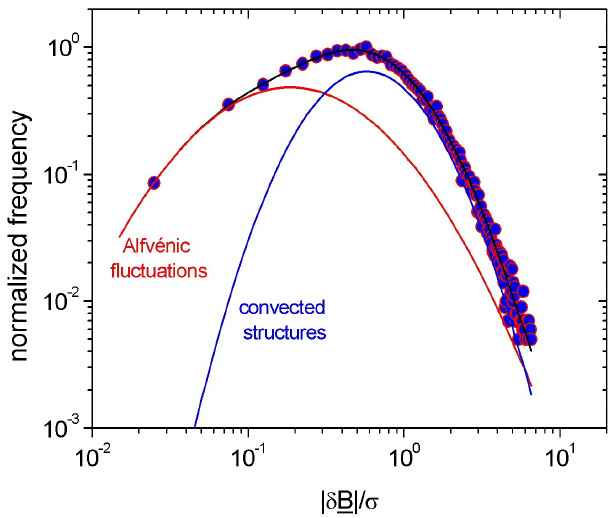
Fig. 5. | δ B (t) | distribution in σ units described by two lognormal components corresponding to Alfv´enic fluctuations and convected structures, respectively (adapted from Bruno et al., 2004).